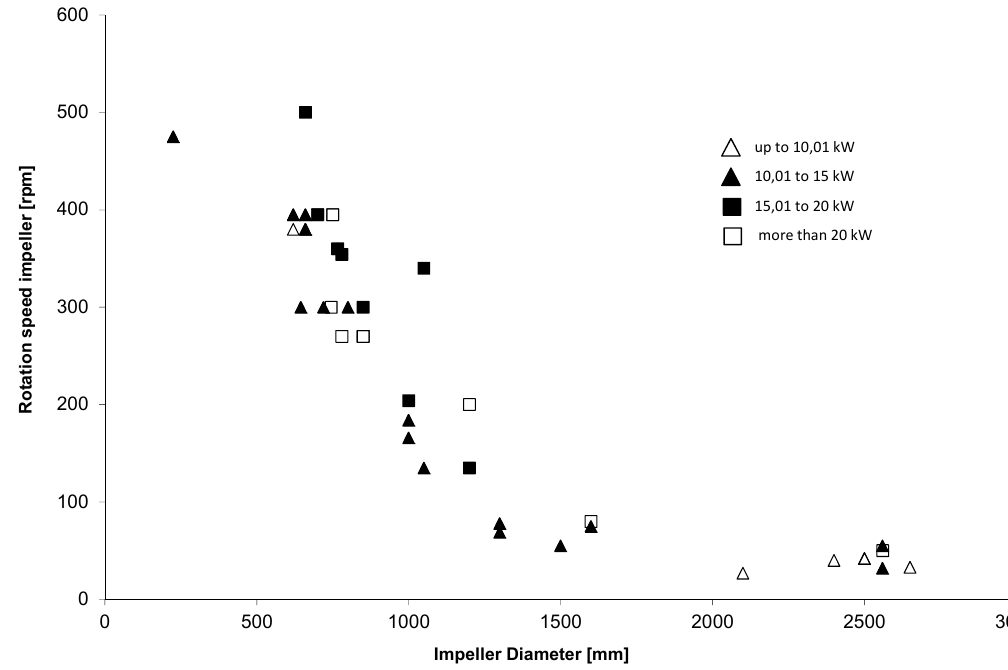
Figure 1. Rotation speed of agitators in relation to the impeller diameter and its respective power requirements of agitation units available on the market ( n = 46) (source: own survey in